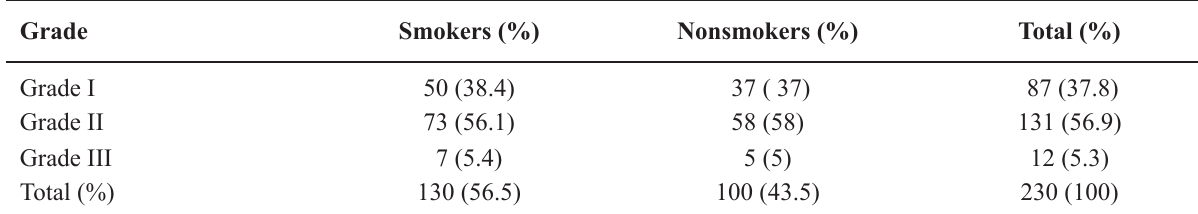
Table 4 – Stratification of the degree of tumor differentiation (Broders classification) of nonsmokers and smokers with cancer of the penis.